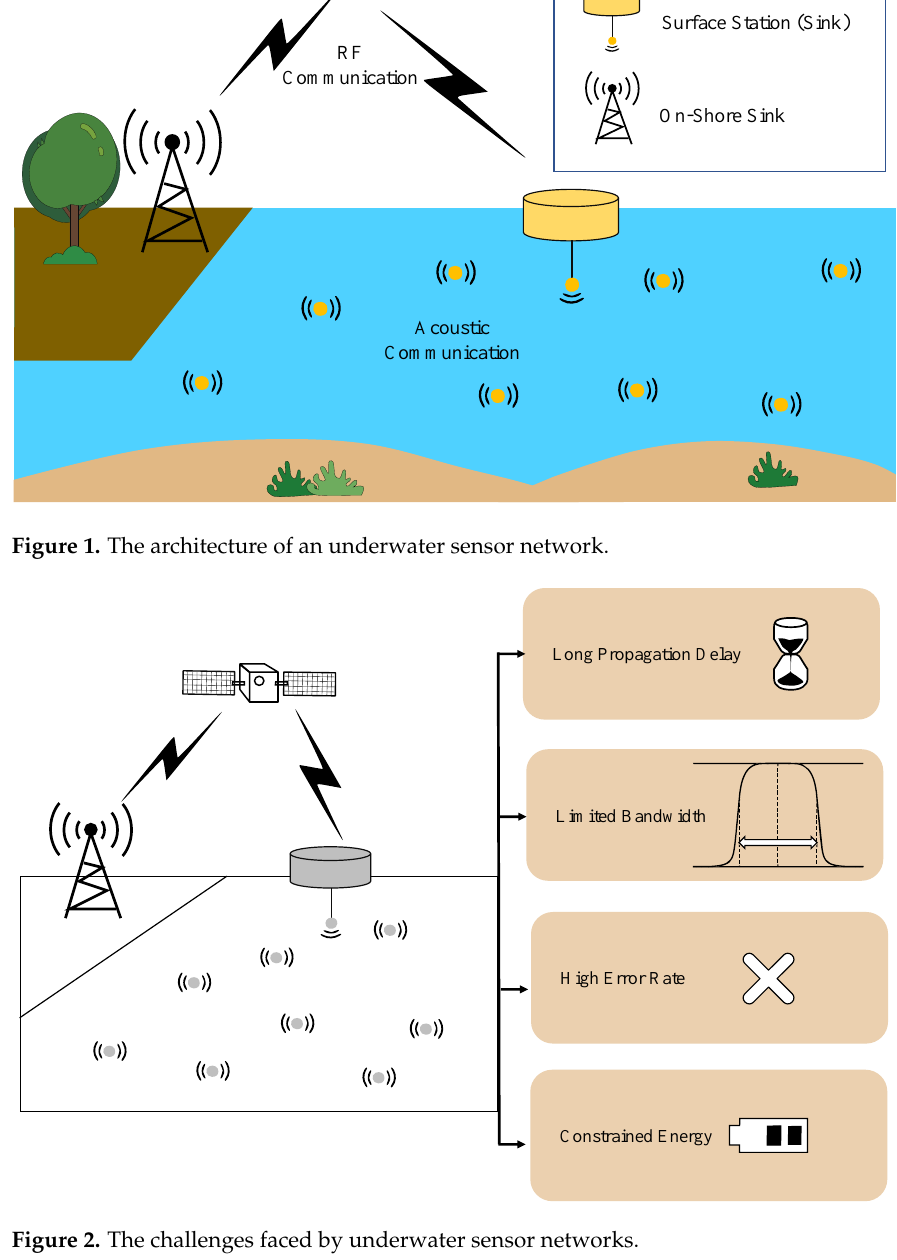
Figure 2. The challenges faced by underwater sensor